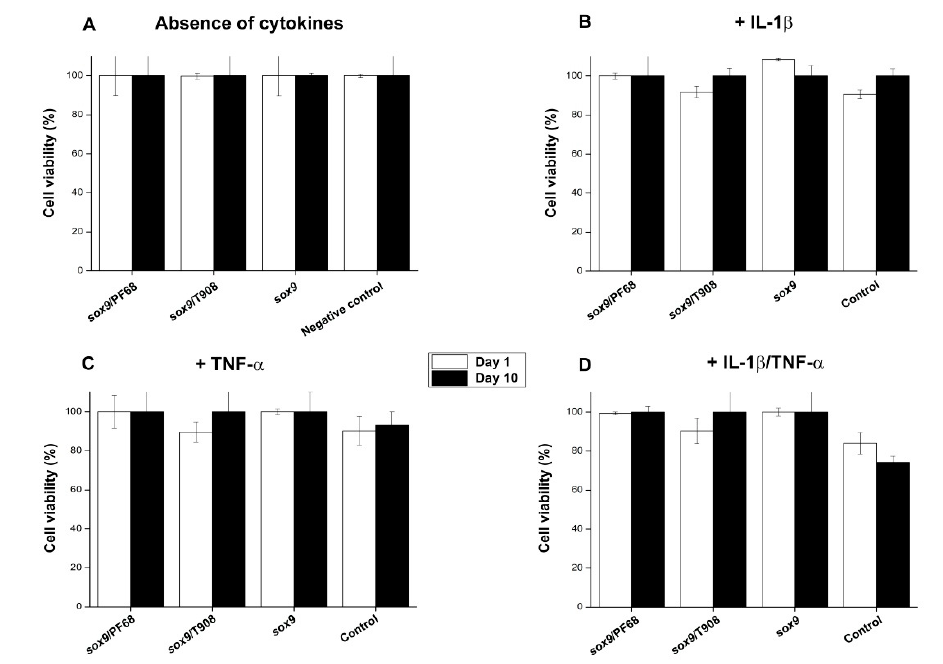
Figure 4. Cell viability in rAAV-FLAG-hsox9 modified human OA chondrocytes using micellar systems. Cell monolayer cultures were directly transduced with the rAAV / polymeric micelles ( A ) or after pre-incubation for 4 h with IL-1 β (10 ng / mL) ( B ), TNF- α (100 ng / mL) ( C ), or IL-1 β / TNF- α (10 / 100 ng / mL) ( D ), as described in Figures 1–3 and in the Materials and Methods.